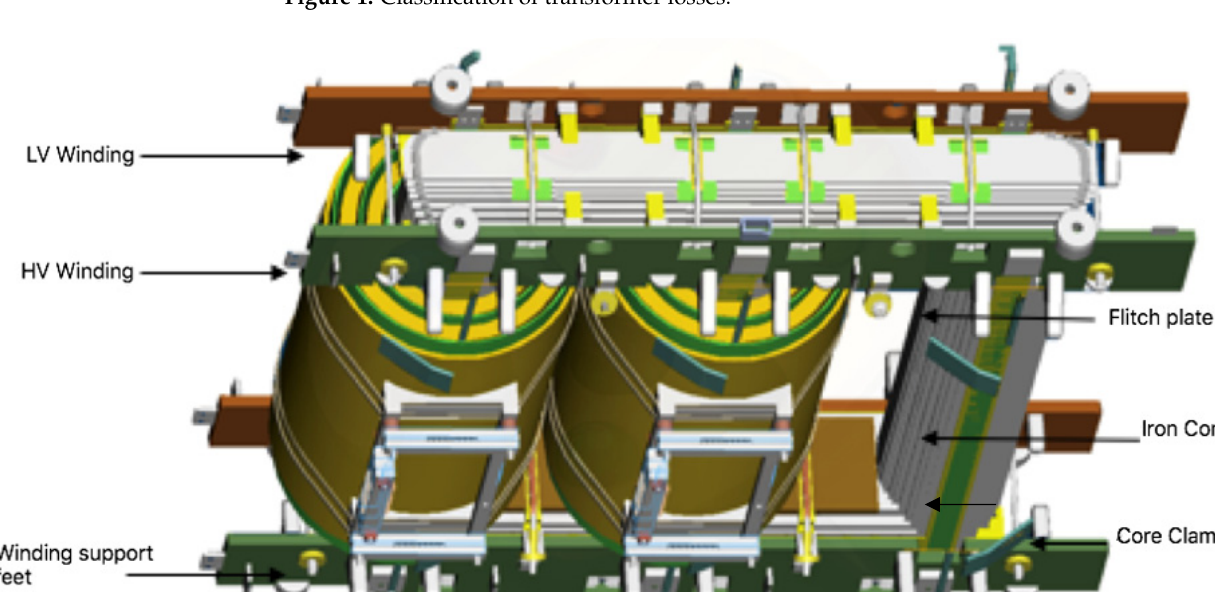
Figure 2. Three-dimensional FEM model of step-up transformer active part components.